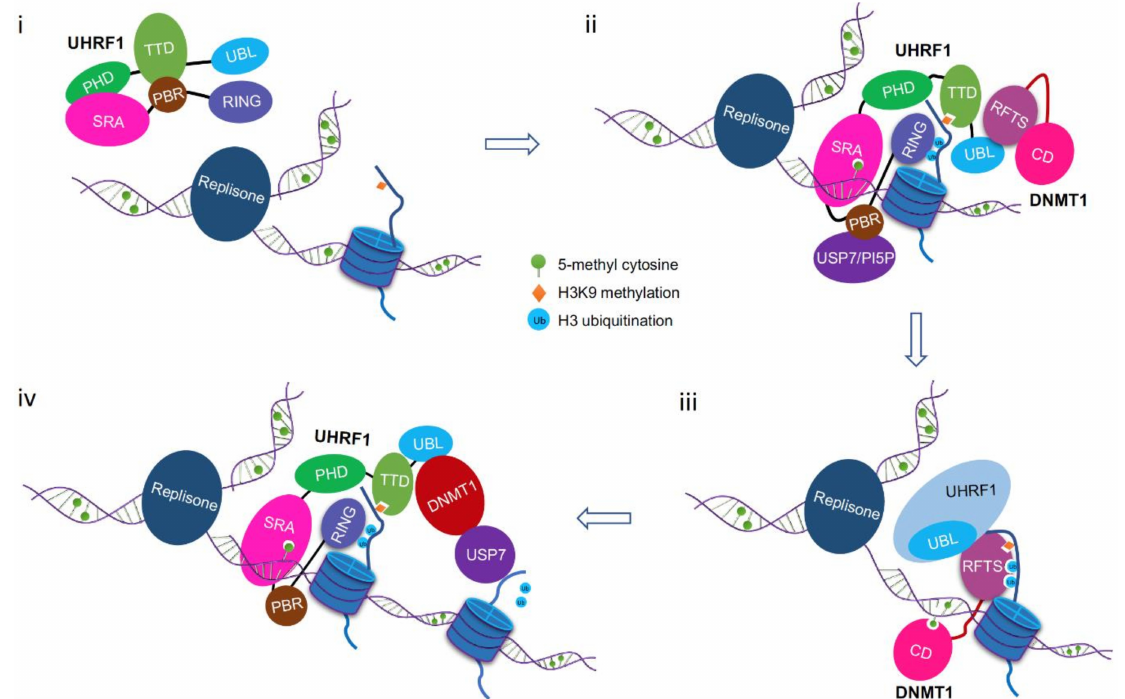
Figure 4. A simplified model for the function of DNMT1/UHRF1 complex in maintenance DNA methylation. (i) UHRF1 adopts a closed conformation in which TTD binds to the PBR motif between SRA and RING finger. (ii) A conformational switch in UHRF1 from inactive closed conformation to active open state is triggered by hemi-methylated DNA binding (and may be facilitated by USP7 or PI5P binding to PBR), which allows TTD-PHD bind to H3K9me2/3 and the RING finger to add ubiquitin to multiple lysine residues of histone H3. (iii) Binding of RFTS to two mono-ubiquitinated histone H3 disrupts the interaction between RFTS and the C-terminal catalytic domain, causing a conformational change in DNMT1 that allows hemi-methylated DNA to access the catalytic center. (iv) After the DNA substrate is fully methylated, DNMT1 is released from the ubiquitinated histone H3 to allow processive DNA methylation along the newly replicated DNA. Again, UHRF1 binds to hemi-methylated DNA first and adds ubiquitin marks to the neighboring histone H3. At the same time, the deubiquitinase USP7 is activated through a currently unknown mechanism to erase ubiquitin marks from histone H3 at methyl DNA fully recovered regions. Likely de-ubiquitination promotes the release of DNMT1 from histone H3 to ensure processive methylation reaction to